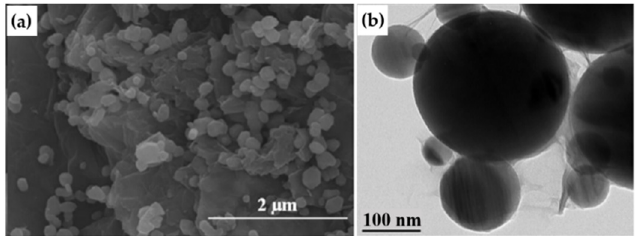
/ TiO 2 [53], ( b ) TEM image of GO wrapped Al 2 O 3